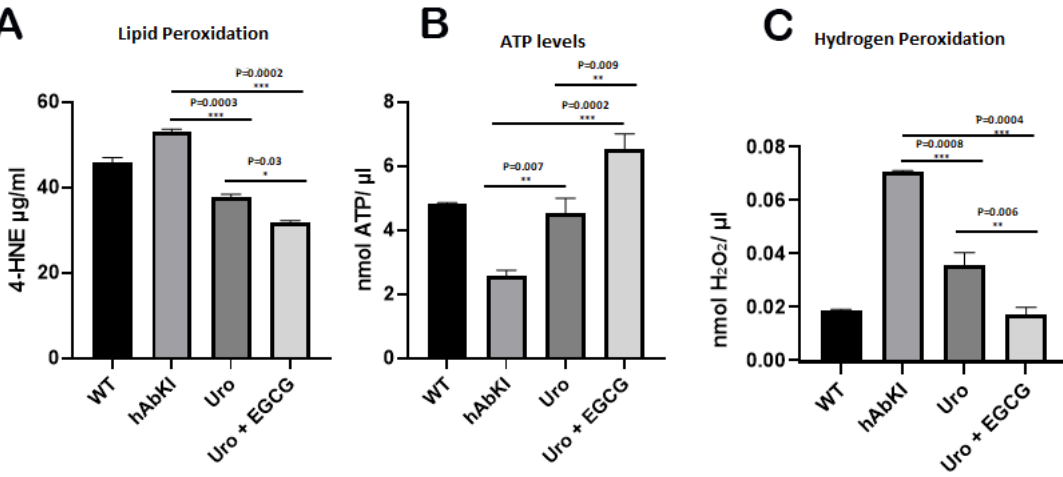
Figure 14. Mitochondrial function. Mitochondrial functional parameters, including lipid peroxida- tion (4-hydroxy-nonenol) ( A ), mitochondrial ATP ( B ) and hydrogen peroxide ( C ) were measured in the cortices of 7-month-old hAbKI and treated hAbKI mice with Urolithin A and EGCG. Data are mean ± SD ( n = 5 for each group). Significantly increased levels of 4-hydroxy-nonenol (lipid peroxidation), hydrogen peroxide and significantly decreased mitochondrial ATP levels were found in hAbKI mice relative to treated hAbKI mice with Urolithin A and EGCG.